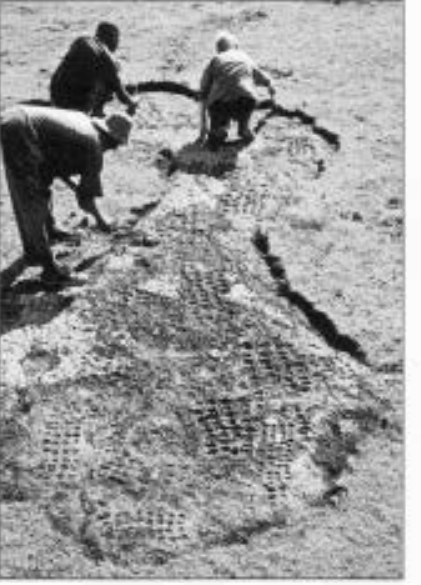
Figure 4 Cleaning engraved gaming boards at Namagolola, Ssi-Bukunja Sub­ County, August